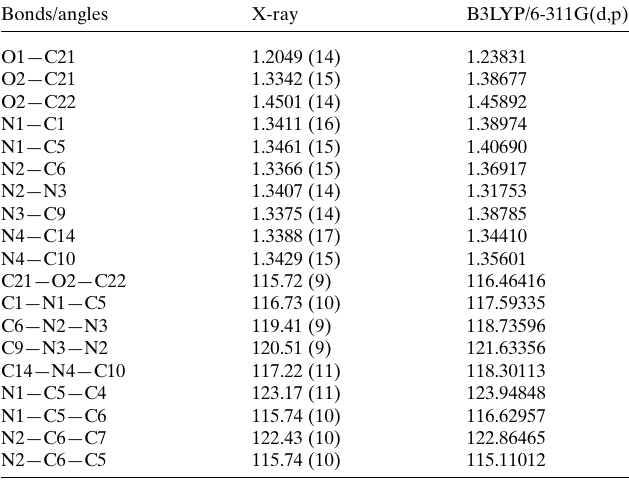
N (cid:2) (cid:2) (cid:2) C contacts (Table 2) and is viewed with the tip at d 3.40 A˚ .